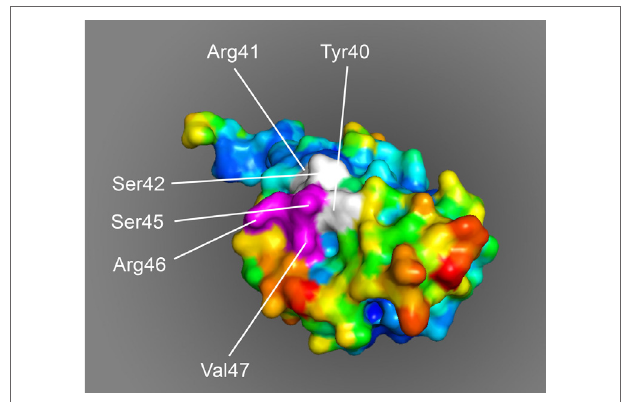
FiGURe 6 | Space-filling model of monomeric myelin oligodendrocyte glycoprotein (PDB accession number 1PKO) in molecular surface representation, colored according to B-factor (blue, low rms/rigid; red, high rms/flexible). The surface-exposed MOG40–48 epitope (YRSPFSRVV) is indicated in white/purple. The P43 and F44 residues, which stick out of the plane toward the reader, are not resolved in the structure, probably due to the high flexibility of this part of the sequence resulting in a diffuse diffraction pattern (109), the V48 residue is buried in the interior of the protein and, therefore, not visible. The putative LIR-motif (F 43 SRV 47 ), which is part of the 40–48 epitope is shown in purple. The surface exposure of this motif enables interaction with the LC3 docking molecule of